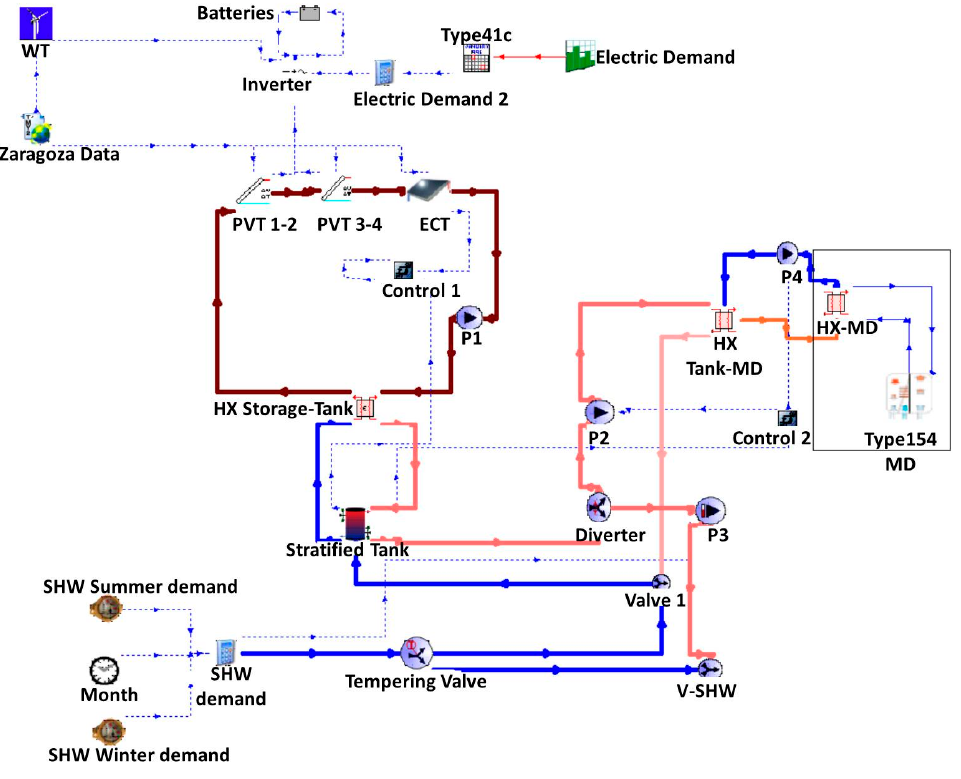
Figure 3. Complete TRNSYS ® simulation.